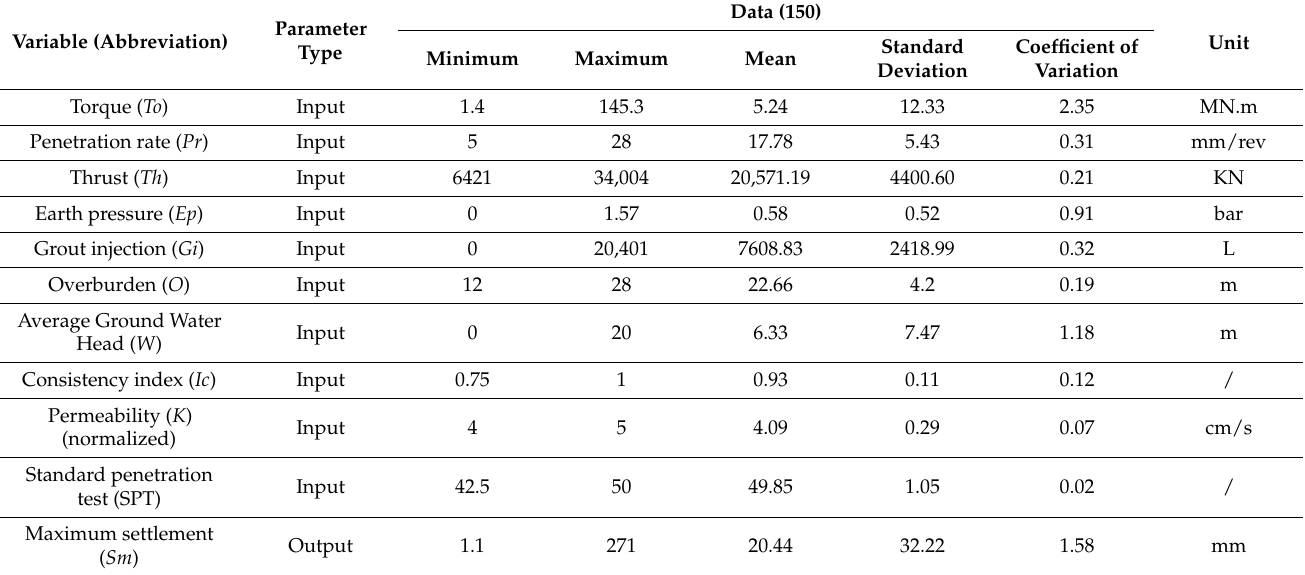
Table 2. Range of various utilized